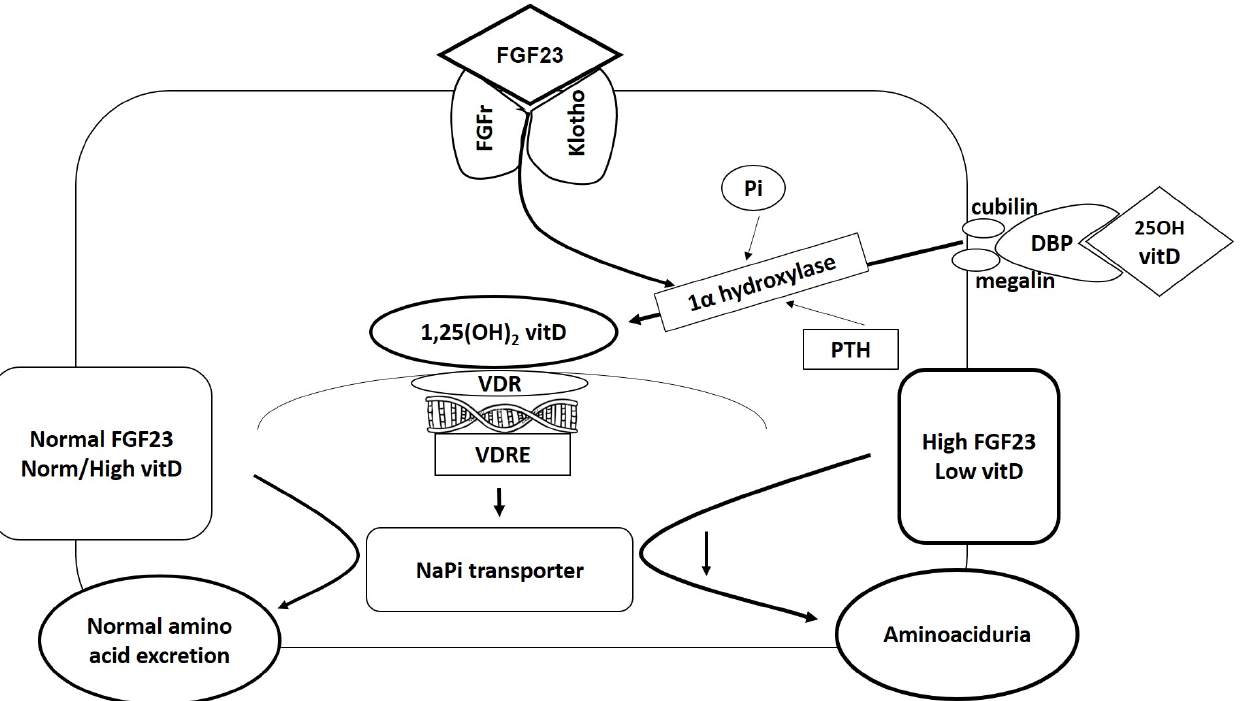
Figure 6. Pathway leading to aminoaciduria in the proximal tubule. The binding of FGF23 to its receptor FGFr occurs in the presence of the co-receptor klotho. Excess FGF23 provokes a fall in 1,25(OH)2vitD circulating levels. FGF23 also in- duces down-regulation of the NaPi transporter.